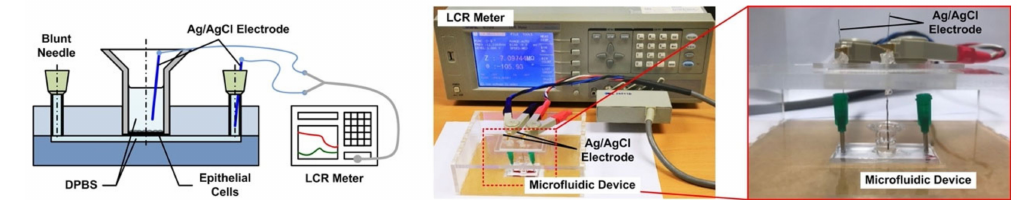
Figure 3. Schematic and experimental photo of the TEER measurement setup used in the